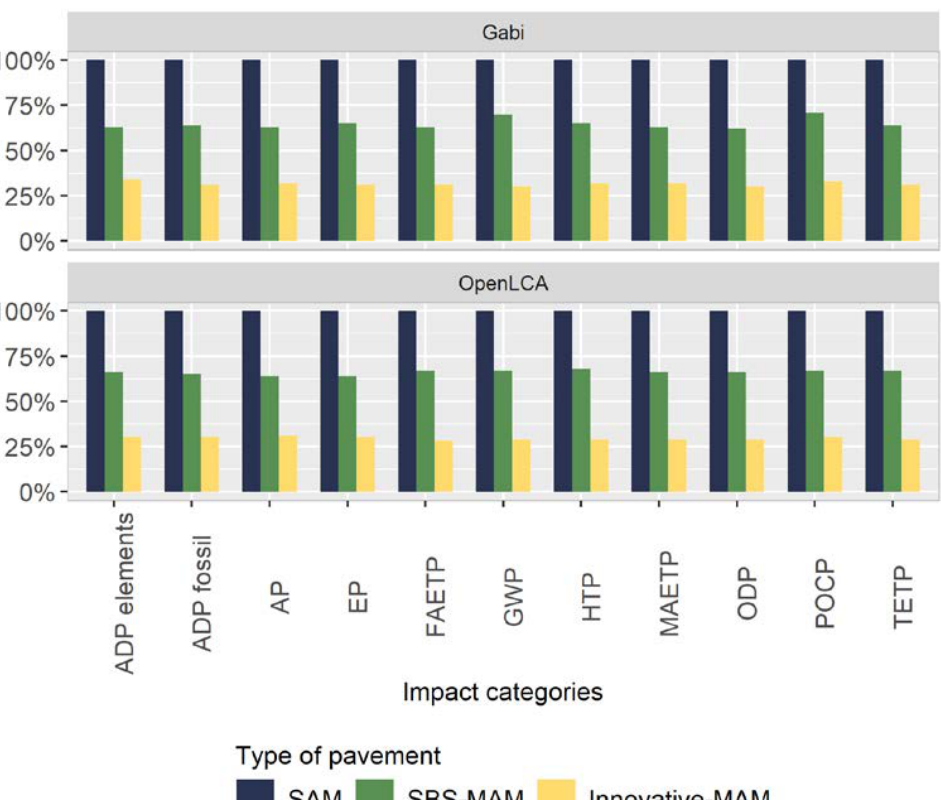
Figure 2. First case study with correspondent layers with fixed thickness. Comparative environmental impact assessment results for all the impact categories for the three cases SAM, SBS-MAM and Innovative MAM considered obtained by the computation with the Gabi ( upper panel) and Open LCA ( lower panel) software. Table 7. Impact results for the three cases, Innovative MAM, MAM (SBS), SAM, with fixed thick- ness.